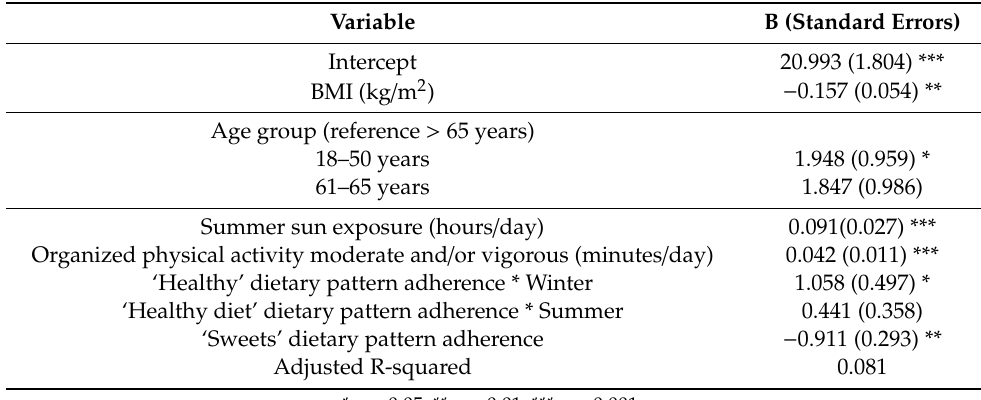
Table 4. Determinants of serum 25(OH)D.